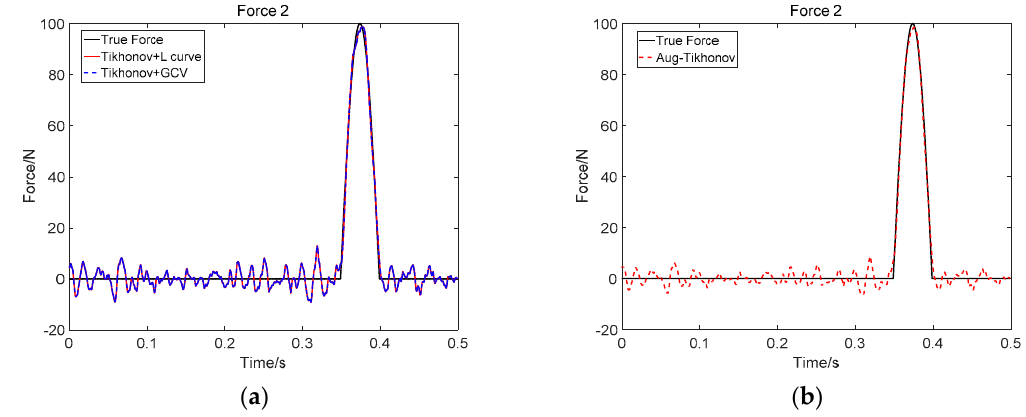
Figure 18. Identification result of two impact loads at SNR 40 dB (Force 1): ( a ) Tikhonov method; ( b ) the proposed method.